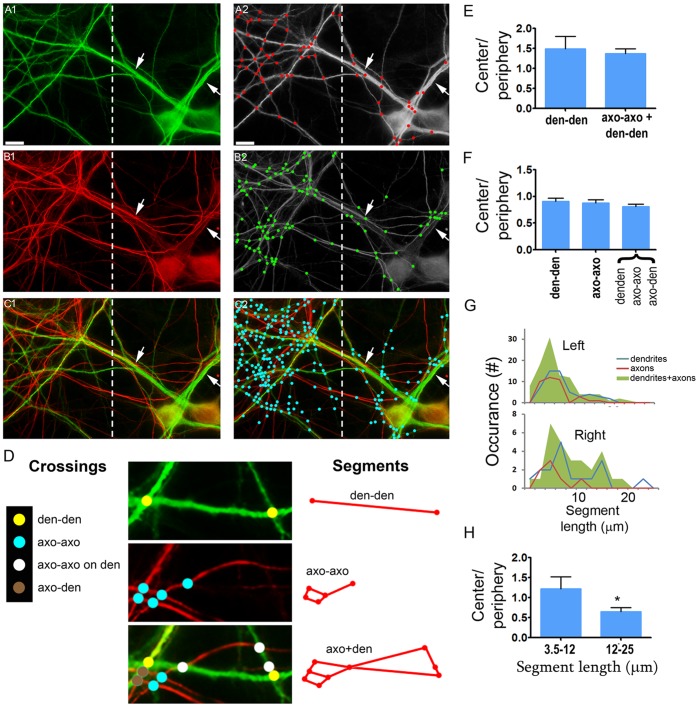
Quantification of preferential axonal traverse of heavily crossing dendritic branches.
I. definition of high vs low frequency crossing regions: (A1–C2) A field which is part of a dendritic hub. (green = dendrites (MAP2), red = axons (NFM)). (A1) The field was divided into two regions: left (“center”) – frequently crossing branches; Right (“periphery”) – rarely crossing branches including dendritic stems (arrows). The crossing points are shown by red spots in (A2). (B1, B2) axons and their crossing points in green (B2). (C1, C2) merge of A1/B1 and A2/B2. Note the higher crossing frequency in the center region compared to the periphery in all cases. II. Nomenclature of the various crossing types (D, left): den-den = crossing points between two dendritic branches; axo-axo = crossing points between two axons; axo-axo on dendrite = axo-axo contacts aligned with den-den contacts; axo-den = contacts between axons and a dendritic branchs. Examples are shown in the middle panels. III. Defining the crossing connecting segment types (titled ‘segments’): den-den = between two den-den crossing points; axo-axo = between two axo-axo crossing points; axo+den = between all crossing points in a merge image. IV. Analysis: (E) Crossing density ratio (at hubs’ center vs periphery), normalized to dendritic length. (F) Ratio of the average length of neuritic segments connecting the crossing points. E and F are combined analysis of 4 hubs. Shown is the mean ± SEM. (G) Length distribution of the connecting segments of the field shown in panels A–C. (H) The segment length distribution in (G) was narrowed to two subgroups. Y axis presents the values of right/left ratio of [#segments (axo+den)/(axo-axo+den-den)]. Shown is the mean ± SEM. Scale: A1–C2 - 7 µm; D, middle panels - 3 µm.